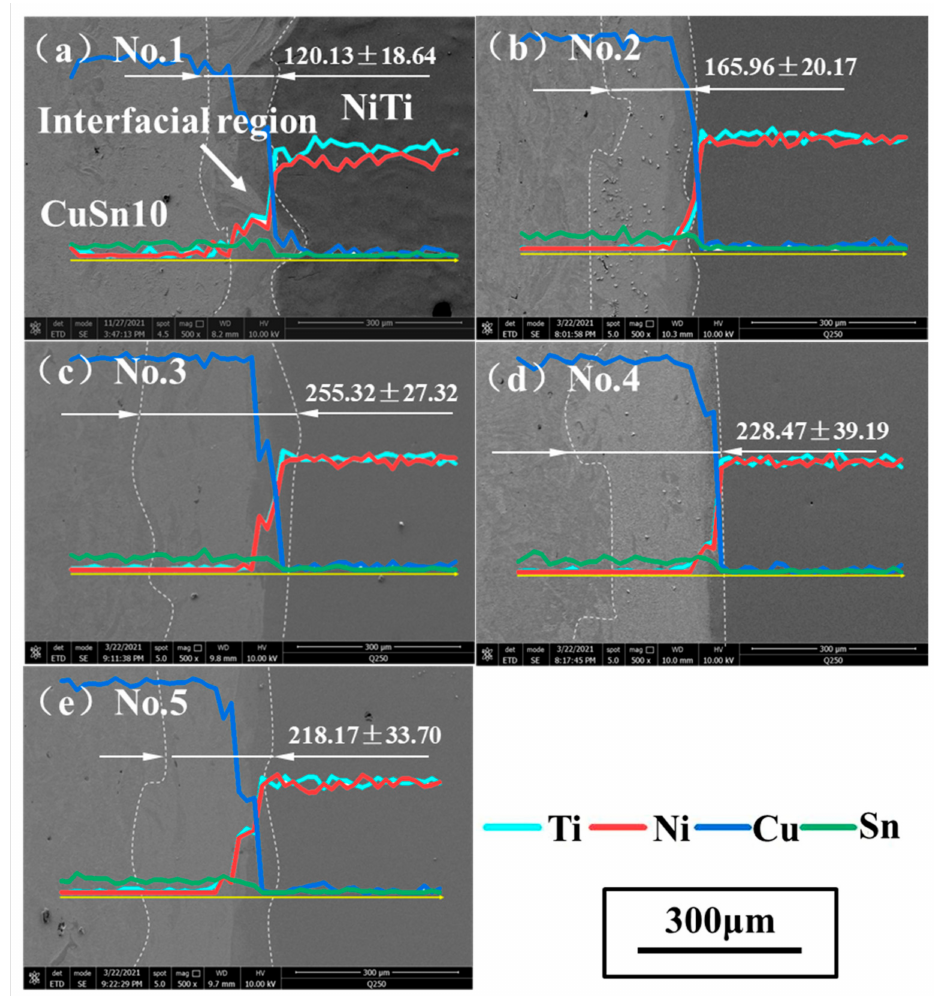
Figure 6. Interfacial SEM images of sample ( a ) No.1; ( b ) No.2; ( c ) No.3; ( d ) No.4; ( e )